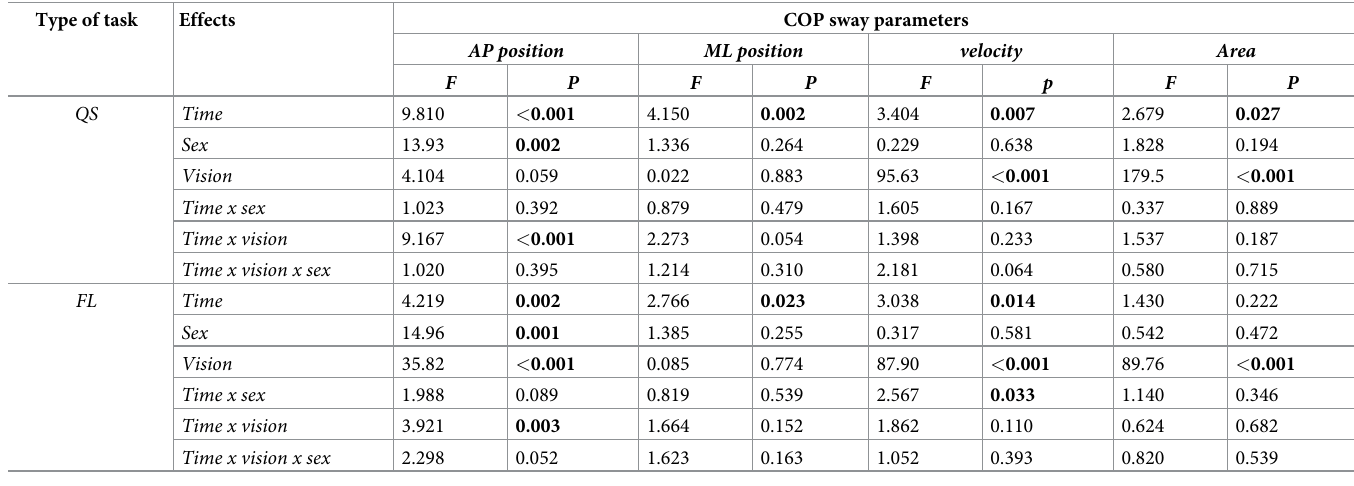
Table 3. Summary of statistical results (ANOVAs) of COP sway parameters. These results depict the effects of fatigue (time), sex, vision, and fatigue-related interac- tions during quiet standing (QS) and standing forward leaning (FL) tasks. The results are shown for the COP data that are not normalized by anthropometric variables (weight, height, and